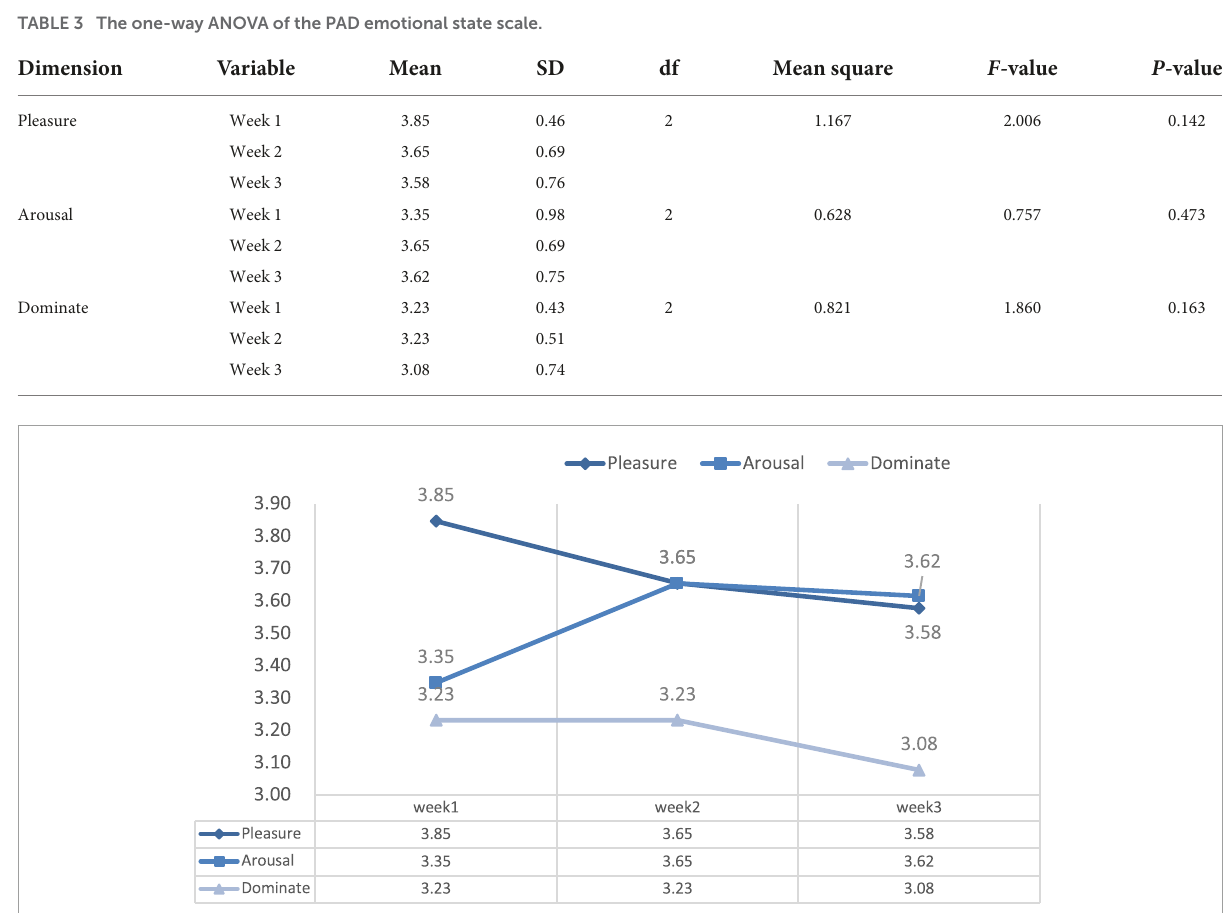
FIGURE9 The mean change of SDNN parameter.